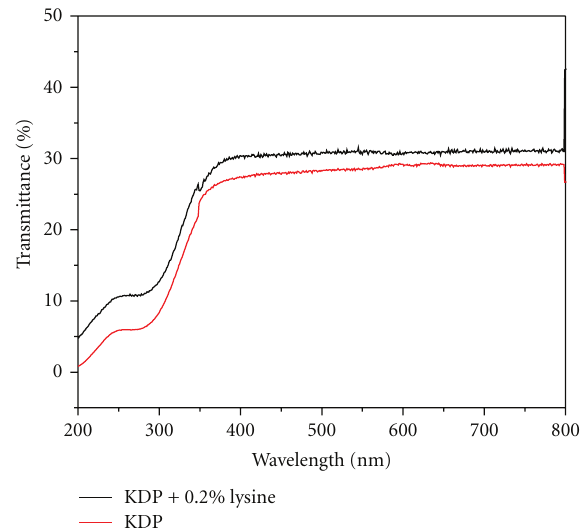
Figure 1: UV-Vis spectrum of pure and doped KDP crystals.